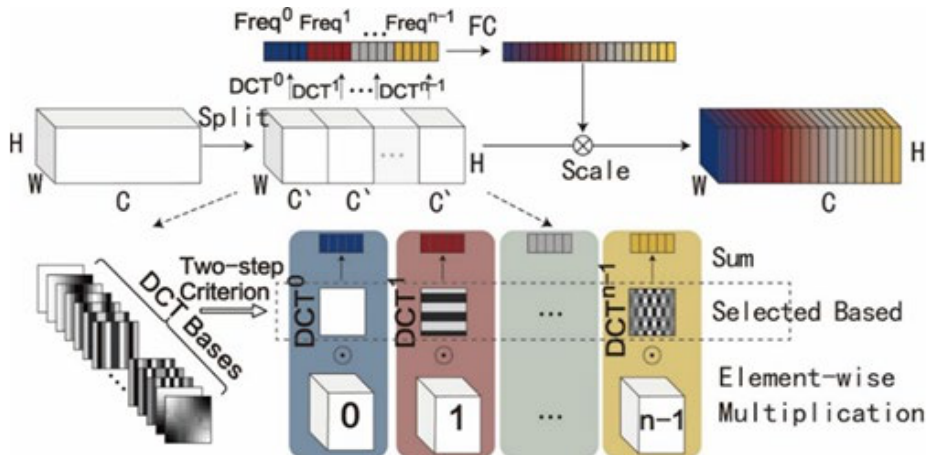
Figure 3. MCA Network Structure (The first step is to calculate the results of each frequency component in the channel attention separately; then, the frequency components are combined and the last step is to screen out the Top-k frequency components with the best performance according to the obtained results).